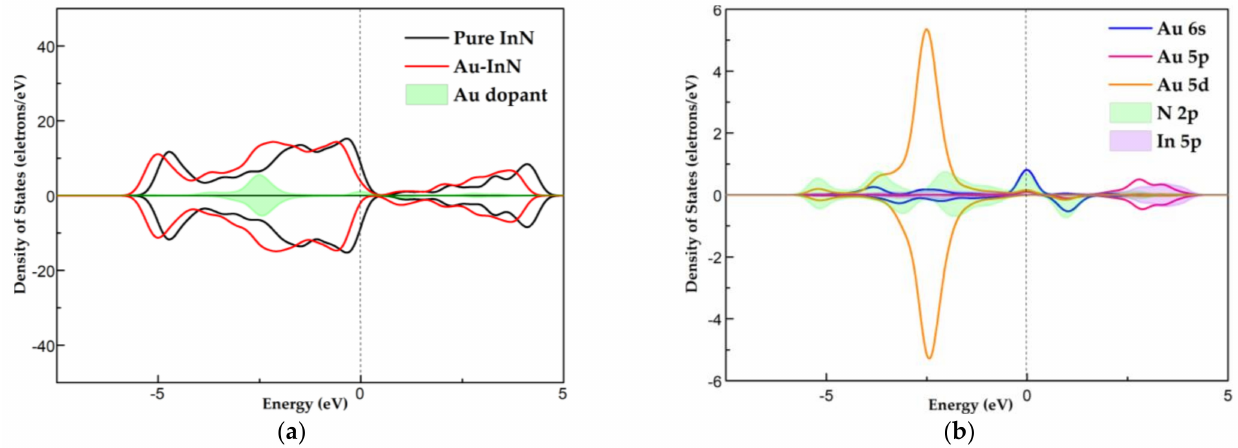
Figure 3. ( a ) TDOS of the system before and after doping. ( b ) PDOS of the doped system, the dotted line indicates the Fermi